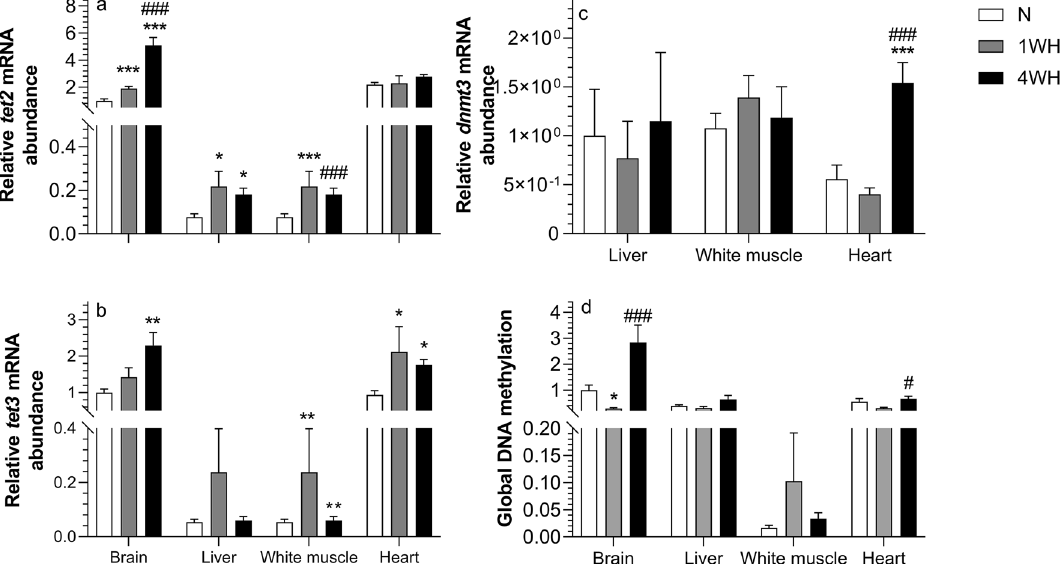
Figure 2. Relative abundance of transcripts involved in DNA methylation dynamics are presented in panels ( a ) ( tet2 ), ( b ) ( tet3 ) and ( c ) ( dnmt3 ), and global DNA methylation is presented in panel ( d ). In all panels, measures in tissues of normoxic controls (N), 1-week hypoxic (1WH) and 4-week hypoxic (4WH) goldfish are presented. Values are means ± standard error of the mean (s.e.m.); sample size = 7–12 per group. Differences between normoxia and chronic hypoxia are indicated as *( p < 0.05), **( p < 0.01) and ***( p < 0.001). Differences between 1 and 4WH are indicated as #( p < 0.05) and ###( p <